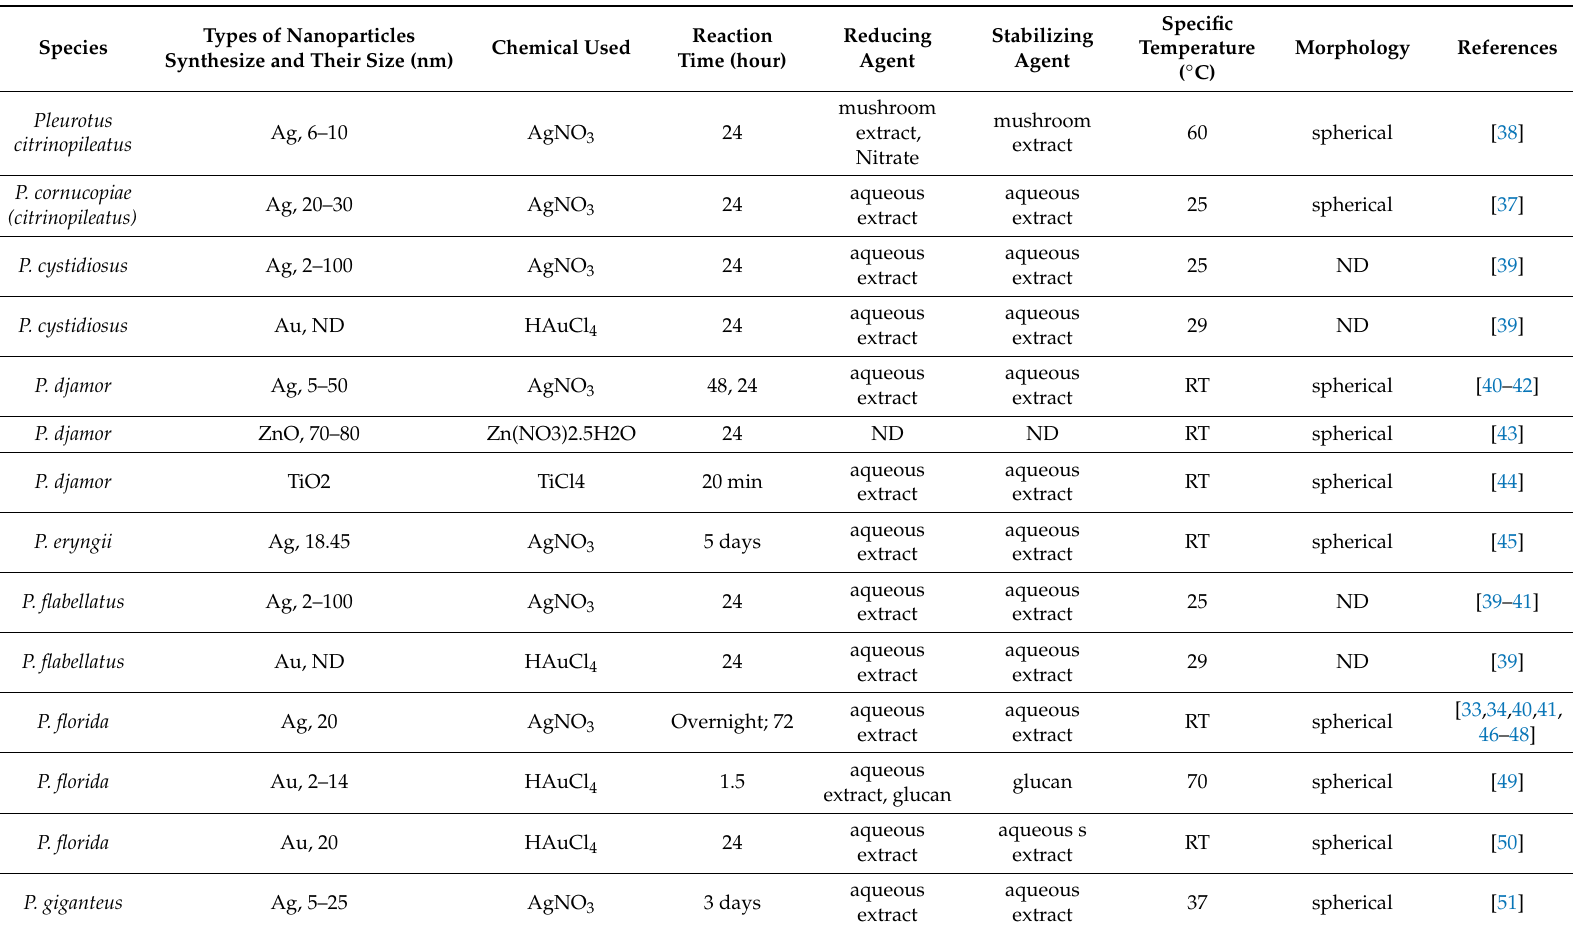
Table 2. Varieties of Pleurotus spp. and their